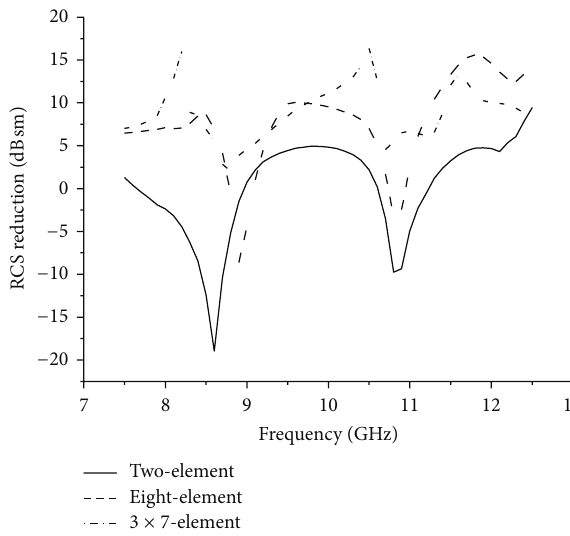
Figure 11: RCS with the frequency of 3 × 7 element.